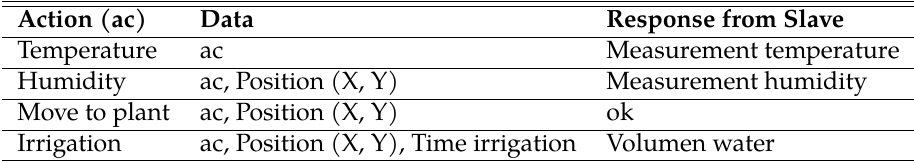
Table 4: Responses between Master and Slave communication